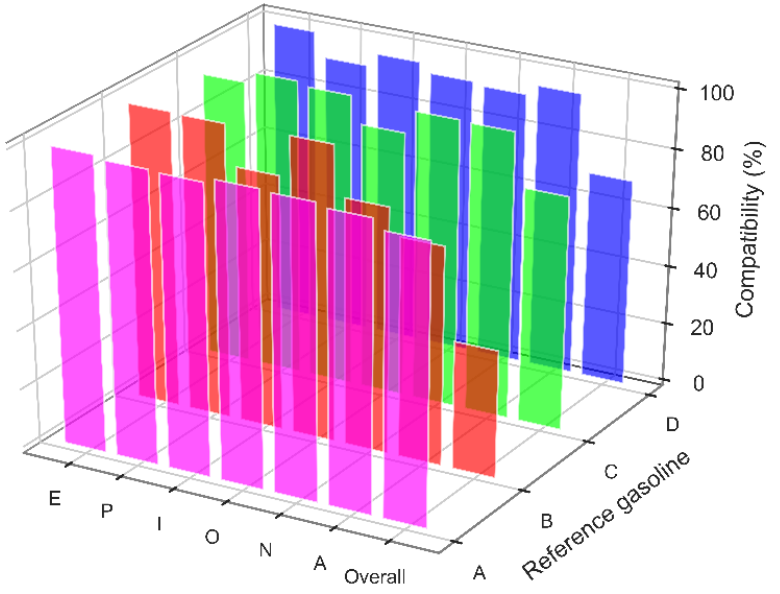
Figure 8. EPIONA class-by-class and overall composition compatibility of optima and bound surrogates of the four validation gasolines (A, B, C, D). The compatibility is calculated as the difference between the volume fraction of each constituting compound.